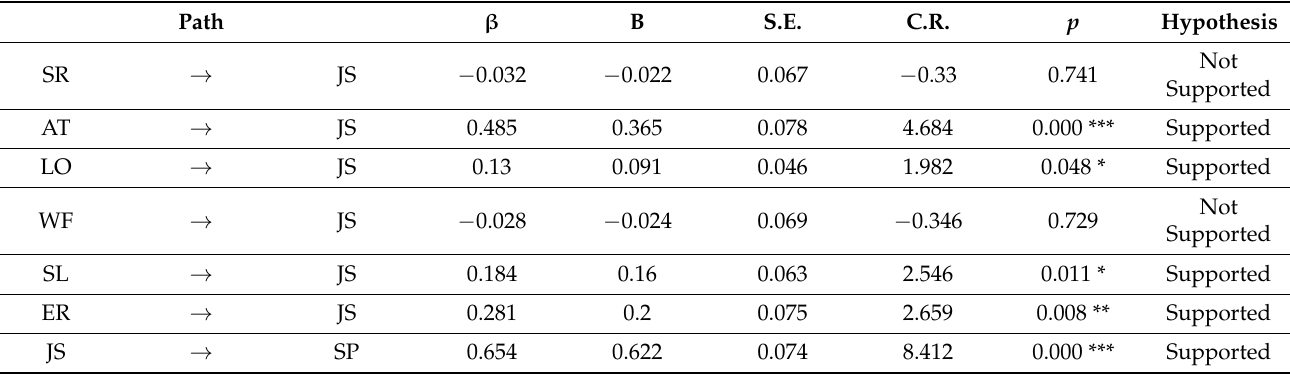
Table 5. Results of hypothesis